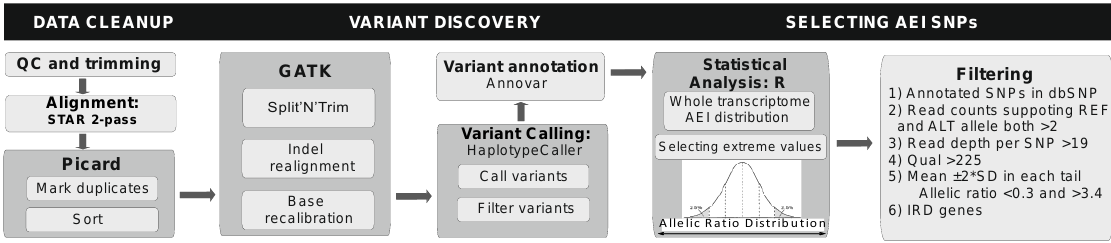
Figure 1. RNA-seq allelic expression imbalance (AEI) analysis workflow. Detailed are all steps contained in the pipeline (see also 2.4. Allelic expression imbalance (AEI) RNA-sequencing analysis). This process is subcategorized into three major blocks: Data cleanup, variant discovery, and selection of AEI single nucleotide polymorphism (SNPs). QC – quality control, GATK - Genome Analysis Toolkit, Indel – insertion/deletion, REF – reference, ALT – alternative, Qual – quality, IRD – inherited retinal disease.